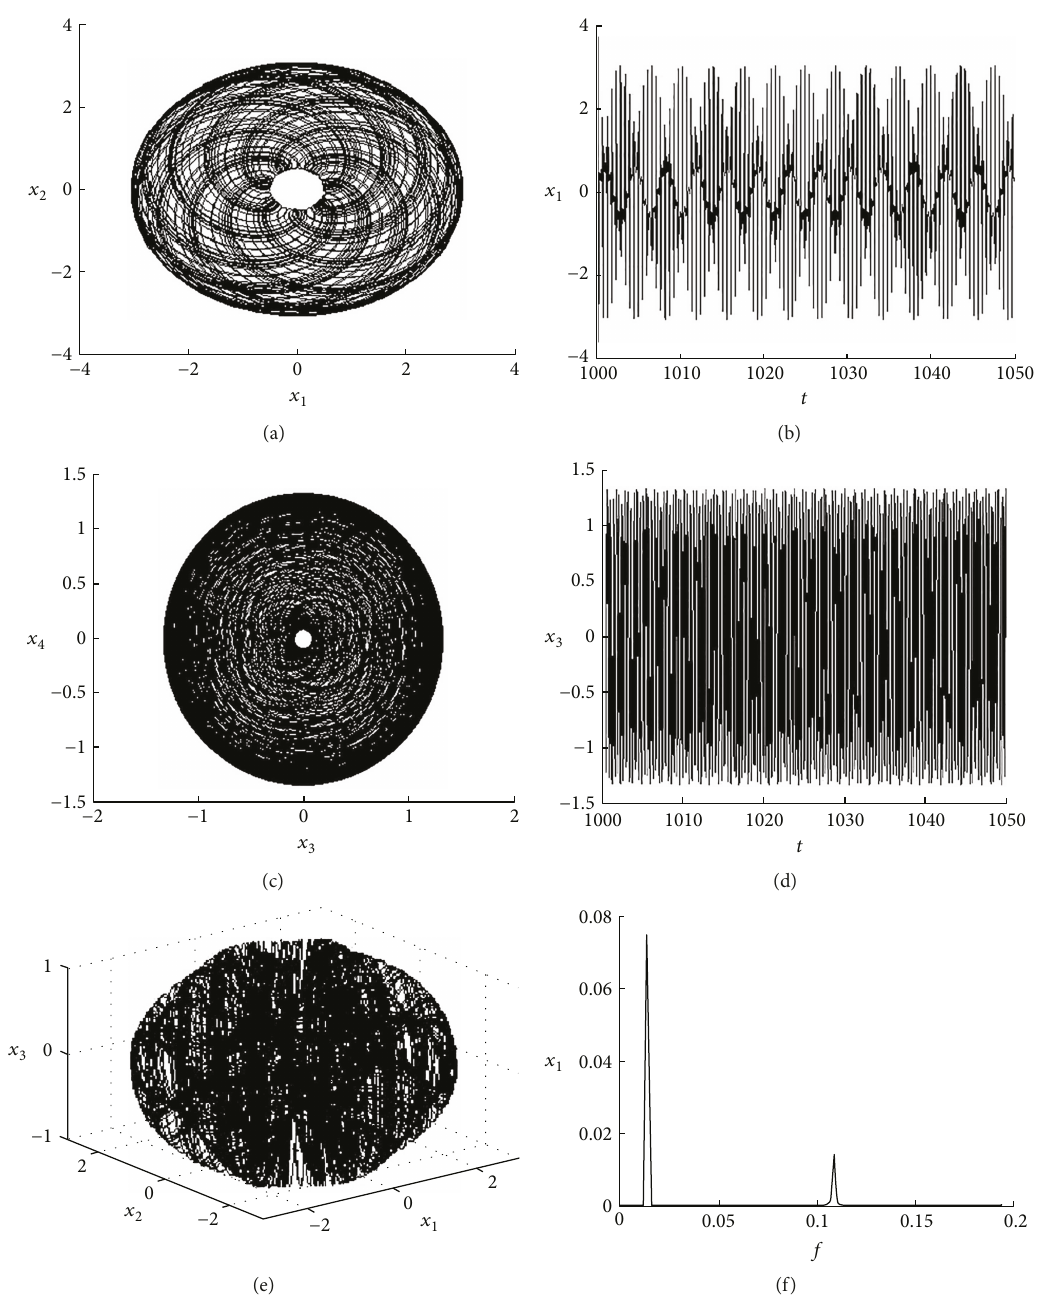
Figure 10: The multiperiodic motion of the blade with varying rotating speeds when Ω (b) the waveform on the plane t , x in the three-dimensional space x